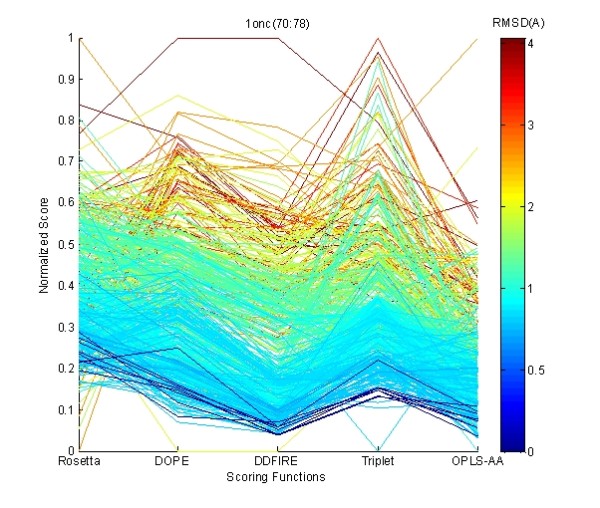
Multiple Scoring Functions Coordinate Plot of Decoys in 1onc(70:78) Decoy Set